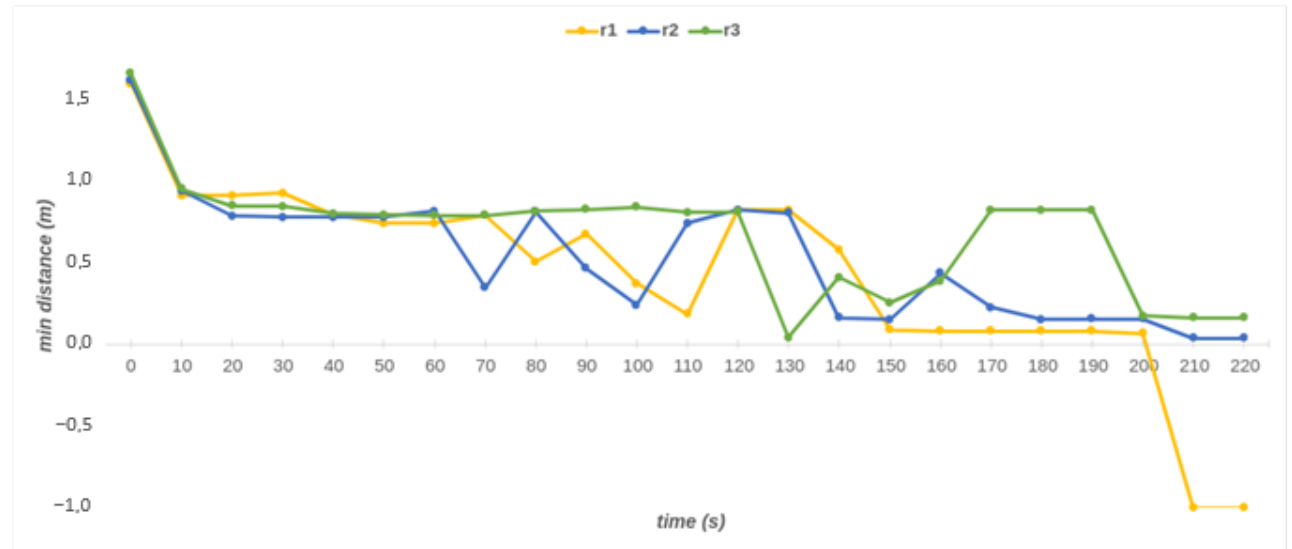
Figure 17. Minimum distances of C3 for three different radii. r1 = 0.1425, r2 = 0.135, and r3 = 0.124.